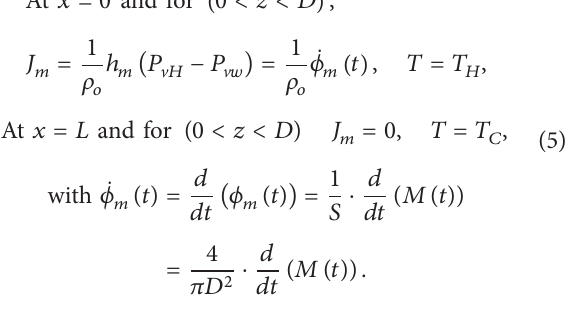
where 𝐽 𝑚 , 𝐽 V , and 𝐽 𝑙 are, respectively, the total mass flow, the vapour, and the liquid mass flow. Structural properties as well as diffusion coefficients in the above model are determined experimentally